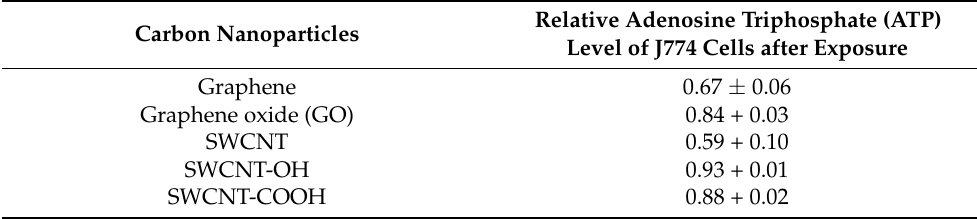
Table 9. Relative ratio of adenosine triphosphate (ATP) level of J774 cells after exposure to function- alized carbon nanoparticles. Data adapted from